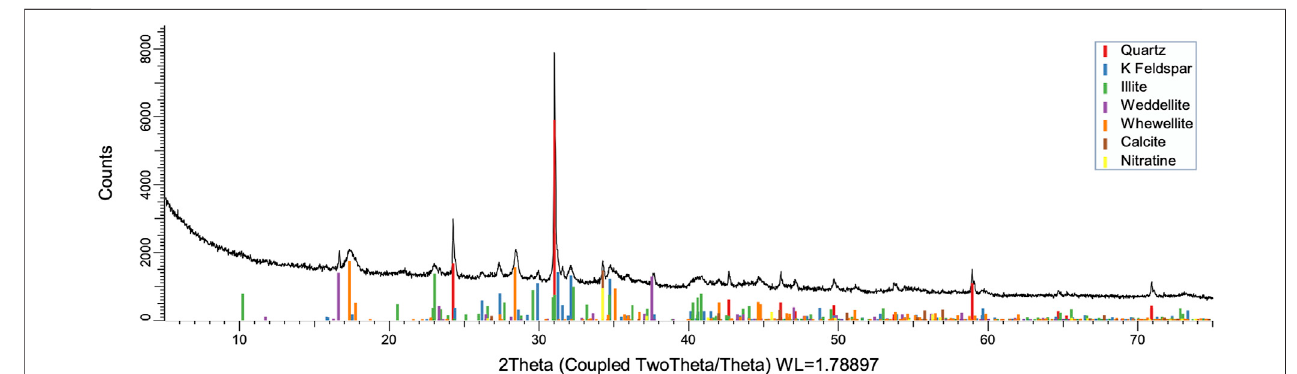
FIGURE 8 | XRD pattern of oxidation residue at 80 ° C and 24